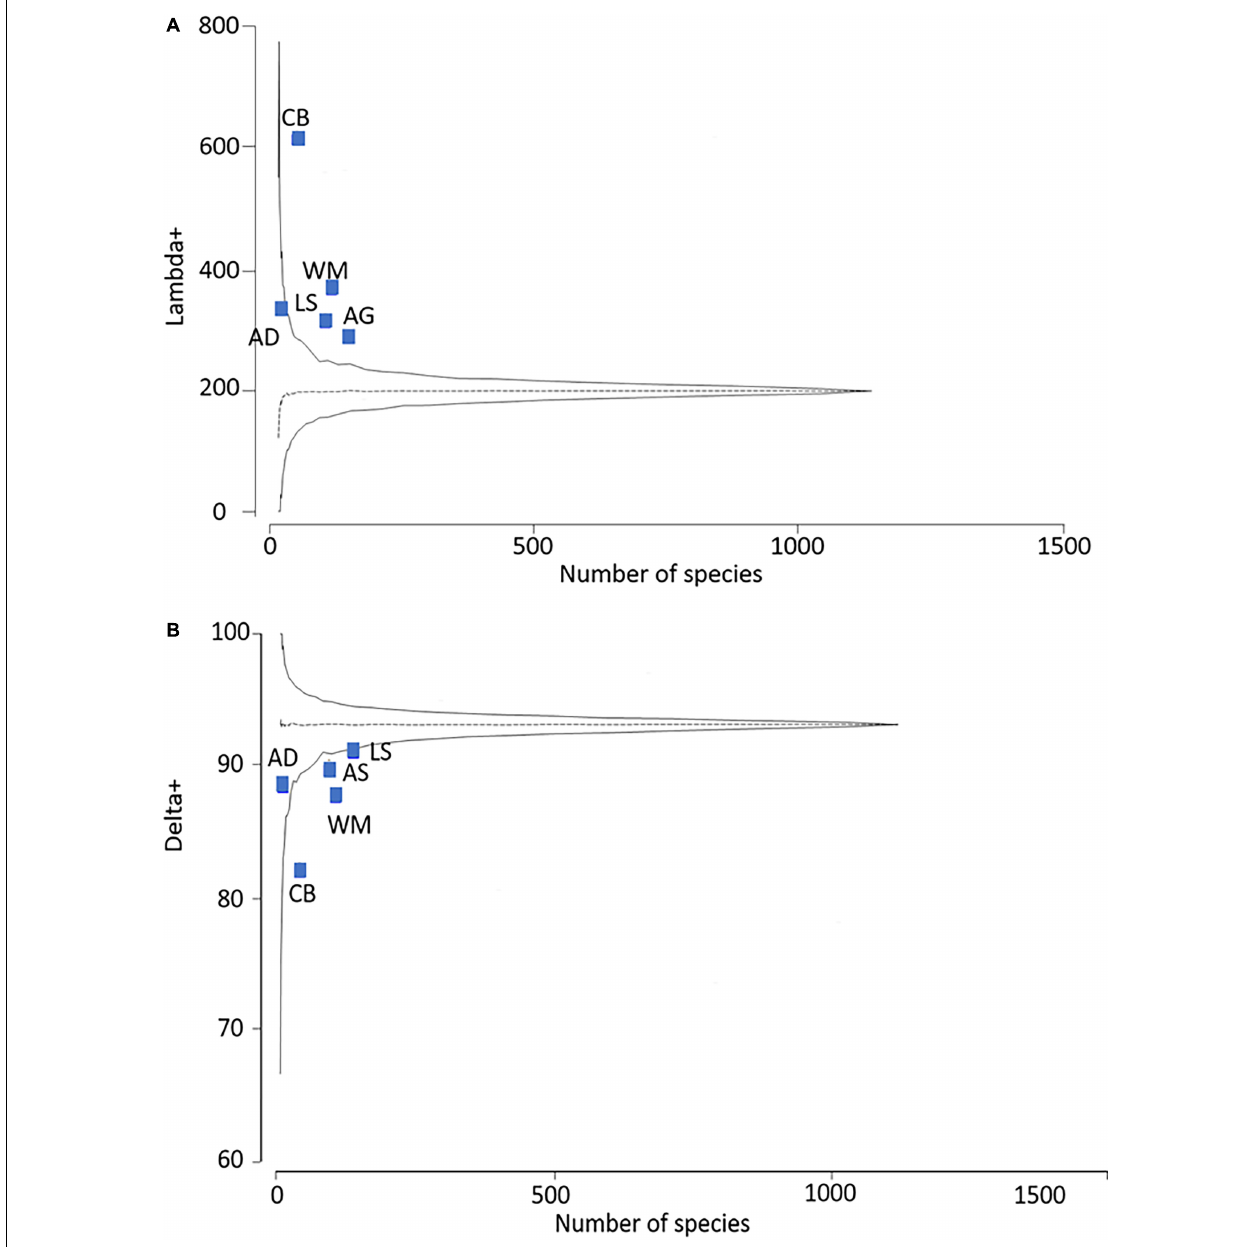
FIGURE 7 | (A) Average taxonomic distinctness (AvTD) and (B) Variation in taxonomic distinctness (VarTD) for the Mediterranean regions superimposed on the 95% confidence limits funnel curve for the expected values of the Mediterranean benthic polychaetes master list. The central line represents the mean value. AD,